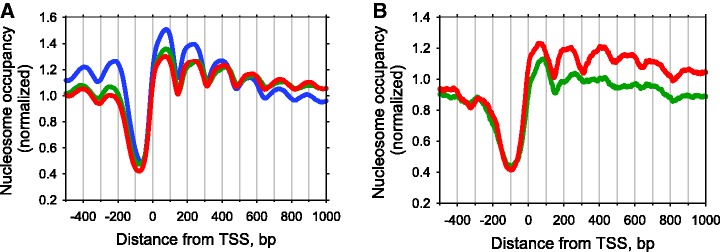
Nucleosome organization around the 5′-end of yeast genes. (A) Overlays of nucleosome occupancy profiles of 4792 S. cerevisiae genes (30) relative to TSS (position 0). Nucleosome occupancy values are either taken directly from Kaplan et al. (29) (blue) or recalculated from Cole et al. (16,27): 3AT set (green) and CC set (red), respectively. In the latter two cases, the NCP fragments 147–152 bp in length were selected to calculate occupancy profiles. (B) Nucleosome occupancy map for 234 genes (out of 4792 genes) that are induced by 3AT by more than 2-fold (25). Note that the occupancy value at each nucleotide is normalized by summing all the nucleosome sequences covering this nucleotide and dividing that number by the average number of nucleosome sequences per base pair across the genome.